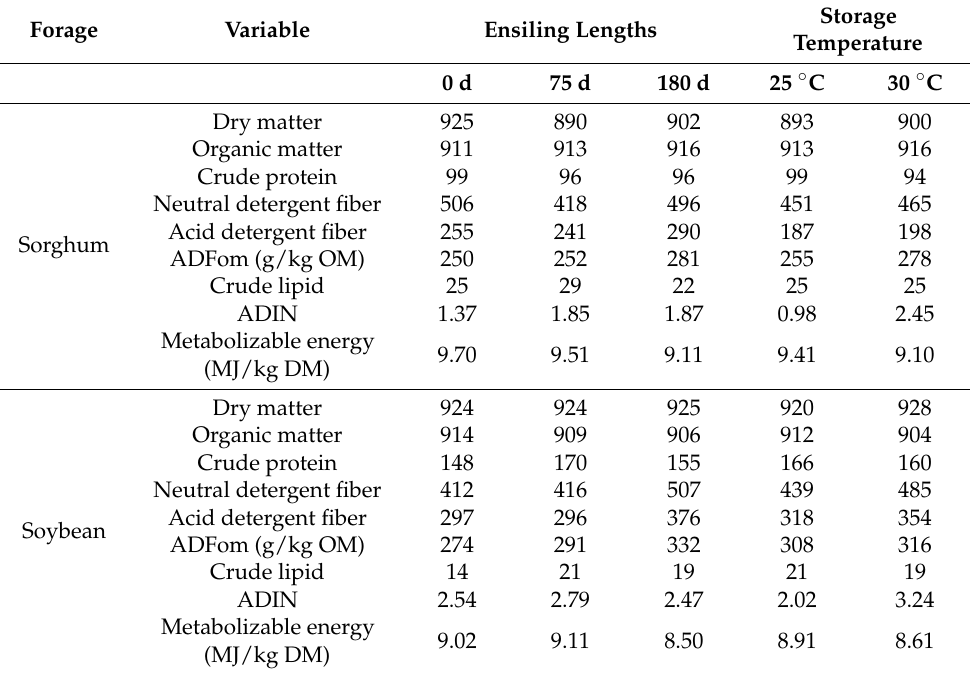
Table 1. Chemical composition (in g/kg DM or as stated) of forages as affected by ensiling length and storage temperature. Forage Variable Ensiling Lengths